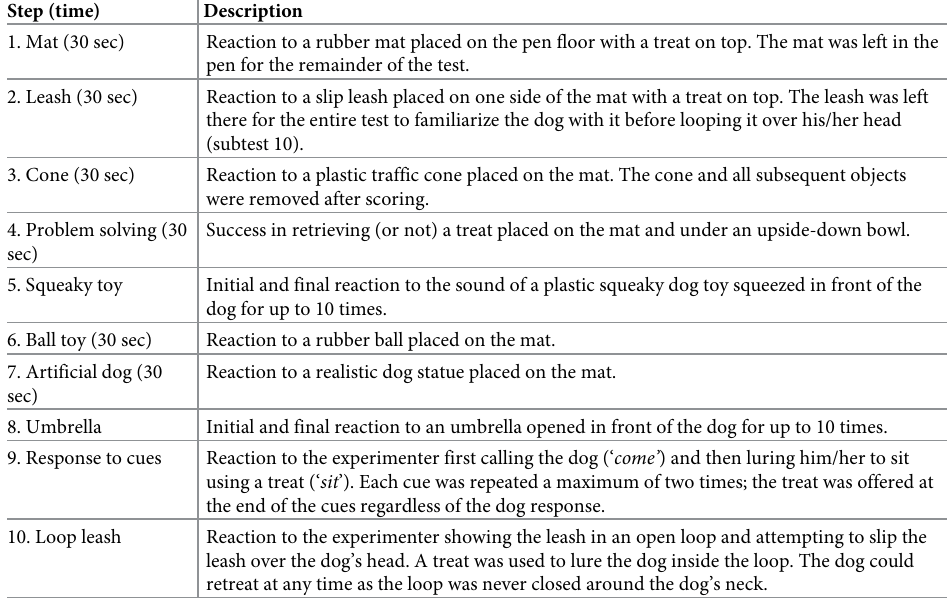
Table 2. Brief description of the steps included in the reactivity test (from Barnard et al. [12]) and duration of each step when